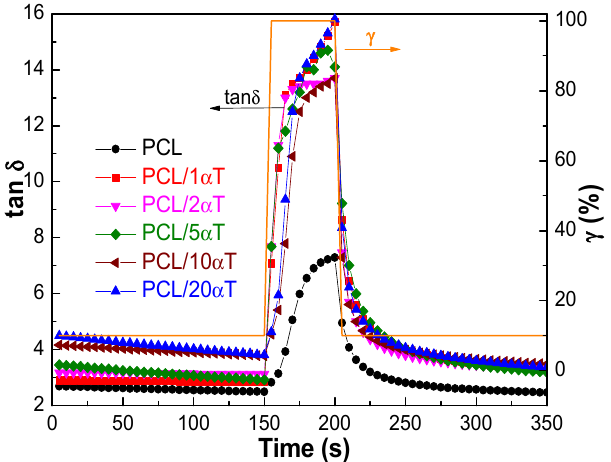
Figure 3. Time-dependent variation of the loss tangent, tan δ , for the PCL solutions containing α -tocopherol.